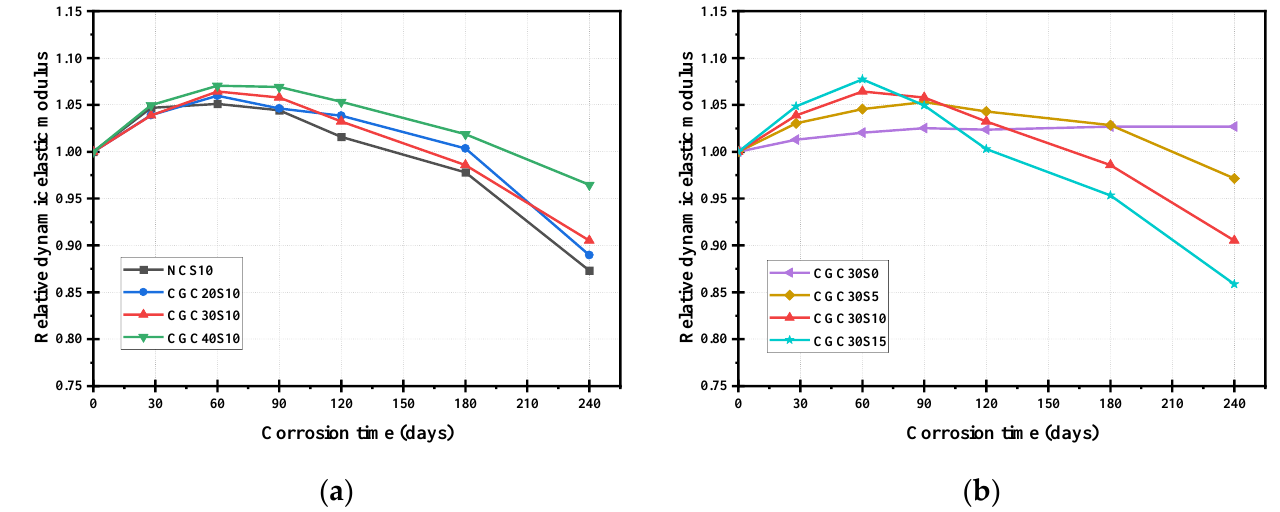
Figure 5. Relative dynamic elastic modulus of specimens at different corrosion times under sulfate attack. ( a ) different concrete; ( b ) different sulfate concentration.